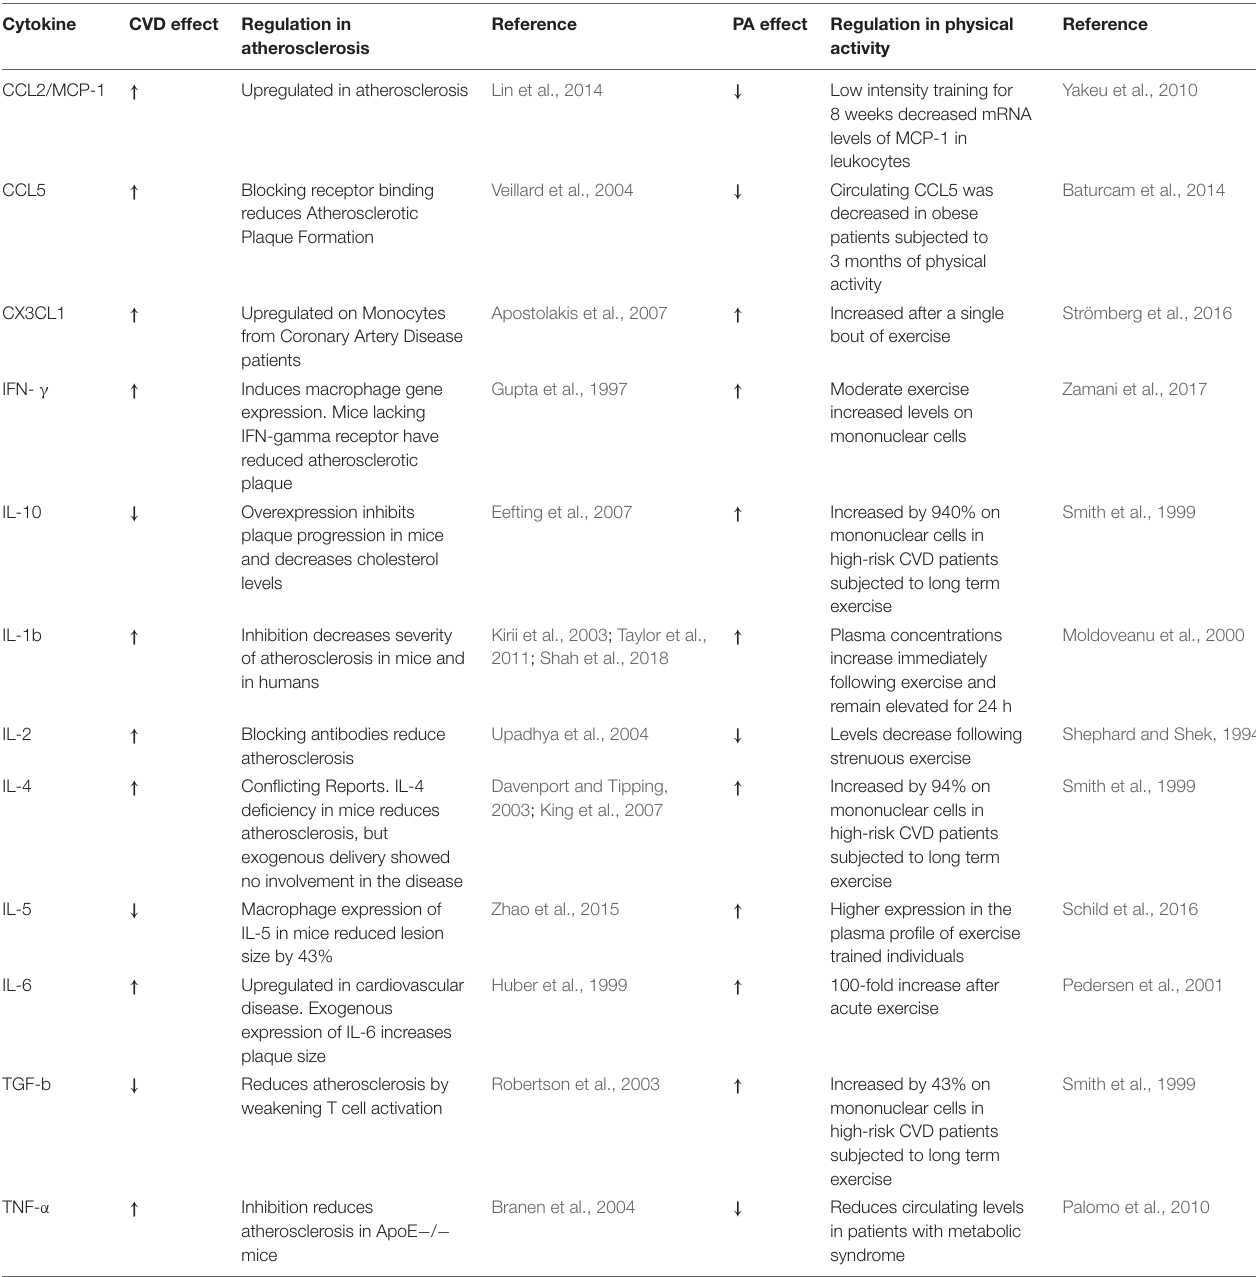
TABLE 1 | Regulation of key chemokines and cytokines in atherosclerosis and physical activity.